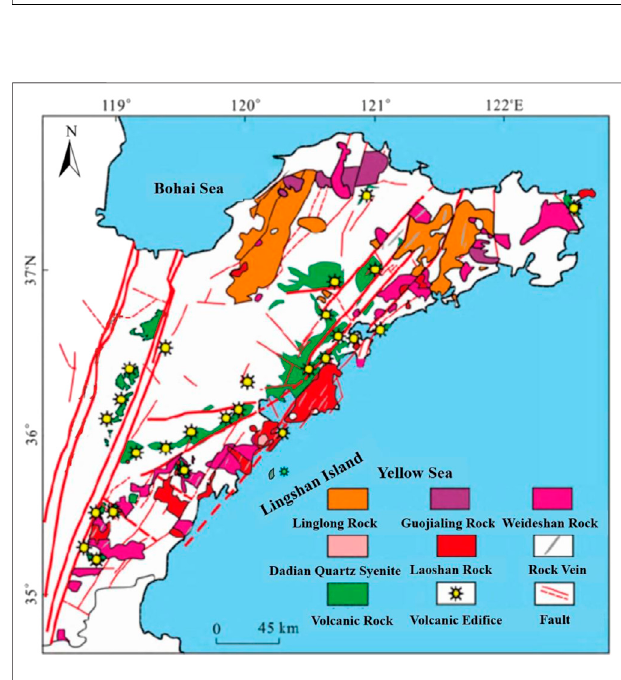
FIGURE 10 | Map of volcanic edi fi ces in the offshore of eastern Shandong Province (Revised after Zhou et al., 2018).